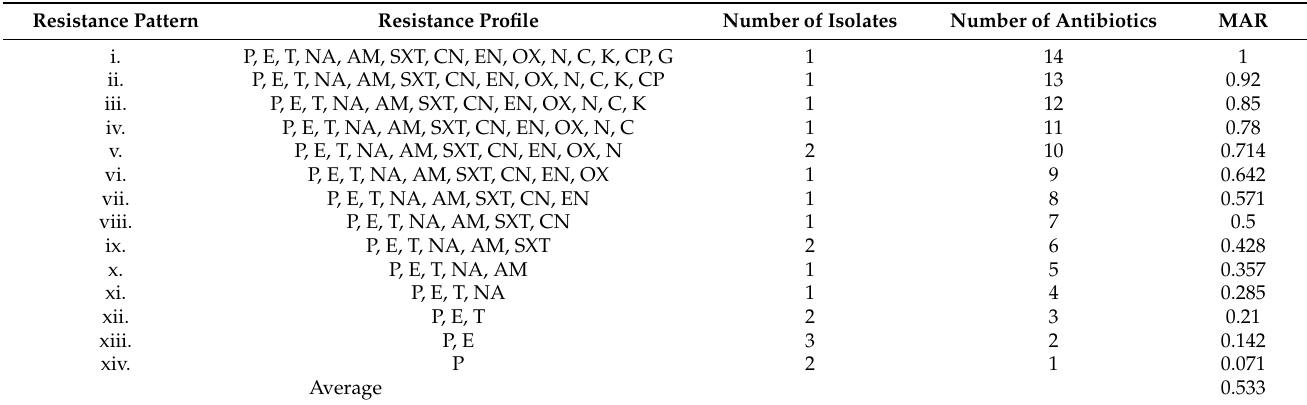
Table 4. Multiple antibiotic resistance (MAR) index and antimicrobial resistance profile of the isolated E. coli strains from carcass shoulder, carcass brisket, carcass thigh, and abattoir effluent ( n = 20). Resistance